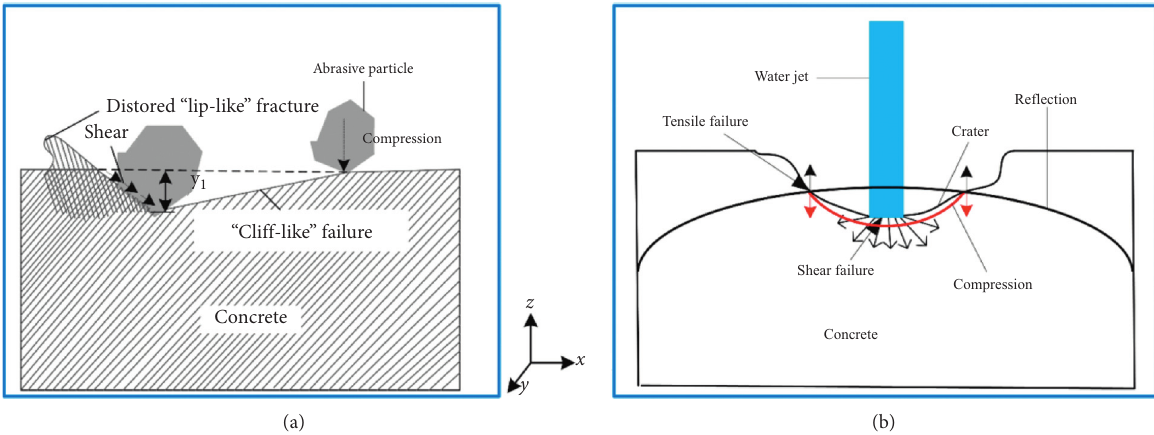
Figure 7: Action mechanism of the PWJ and AWJ crushing of concrete. (a) Action feature of the abrasive particles [2]. (b) The action property of PWJ.